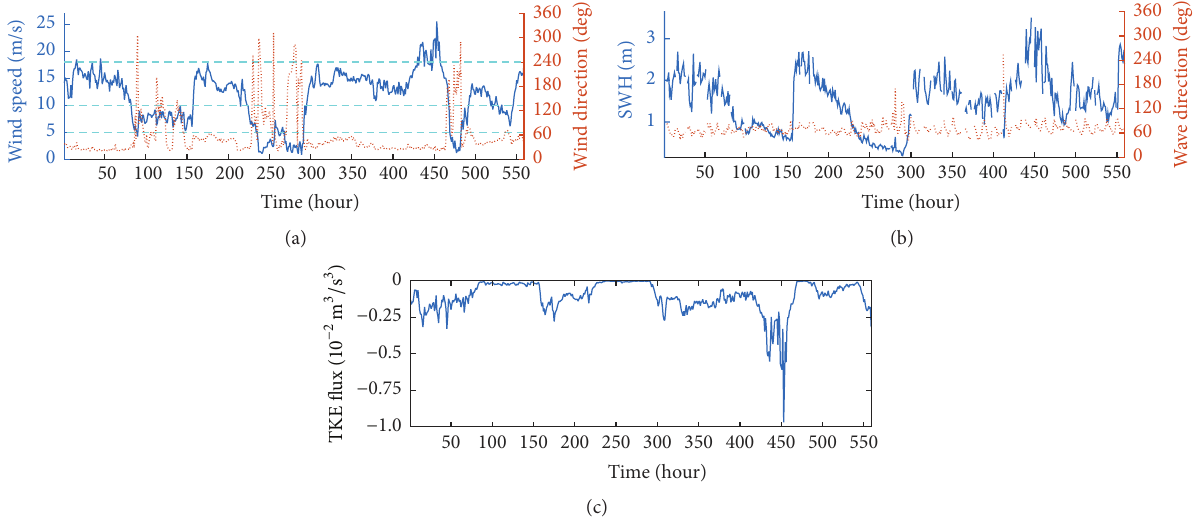
Figure 3: (a) The wind speed and wind direction measured by the anemometer, (b) the SWH and peak wave direction measured by the buoy, and (c) the TKE flux through the sea surface due to whitecapping. The cyan dashed lines in (a) denote the wind speeds of 5m/s, 10m/s, and